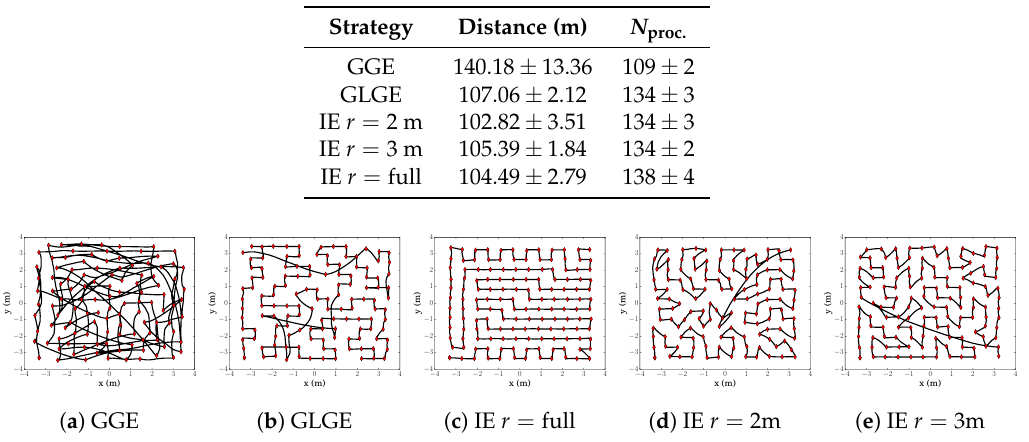
Table 5. Mean value and standard deviation over five runs for scenario S1. Process exploration: Total travelled distance and number of collected process measurements ( N proc. ) required to achieve NMSE of 0.18 with respect to the ground truth.